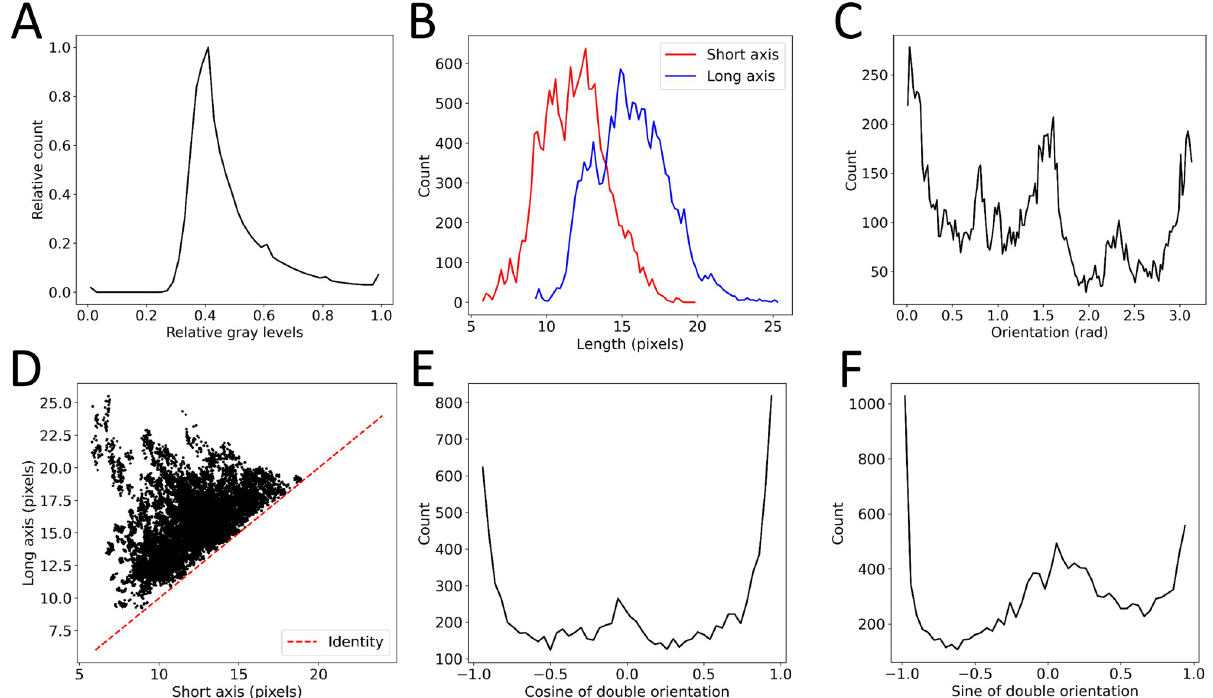
Fig 2. Exploration of the data set. A: relative gray level distribution over the entire dataset. B: Distributions of long axis, in blue, and short axis, in red, in the training set. C: distribution of the raw orientation in the training set. D: Relationship between short and long axes in the training set, the red dashed line shows y = x. E-F: Distribution of the cosine (E) and sine (F) of double the orientation.